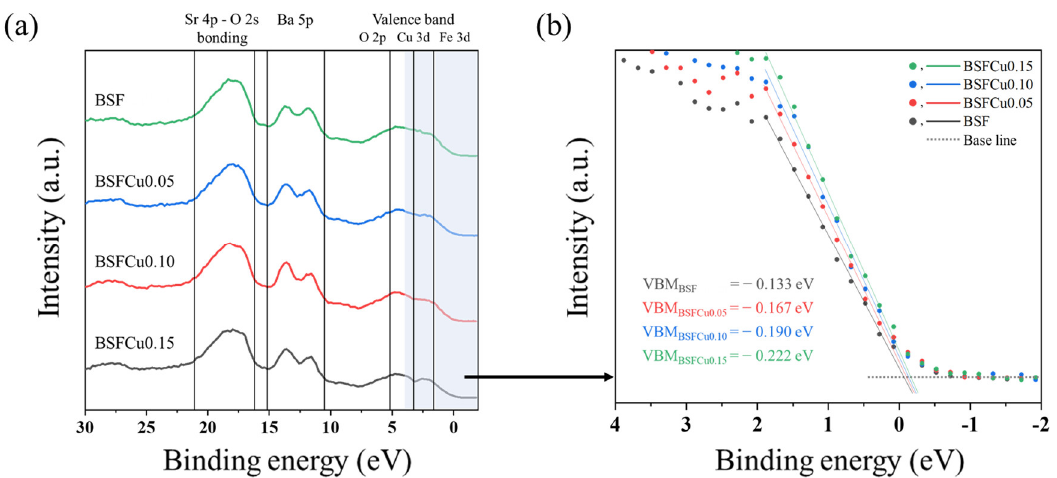
Figure 5. ( a ) Valence band (VB) spectra normalized to the integrated intensity for BSFCux; ( b ) linear fit of the leading edge of VB used to obtain the valence band maximum (VBM).